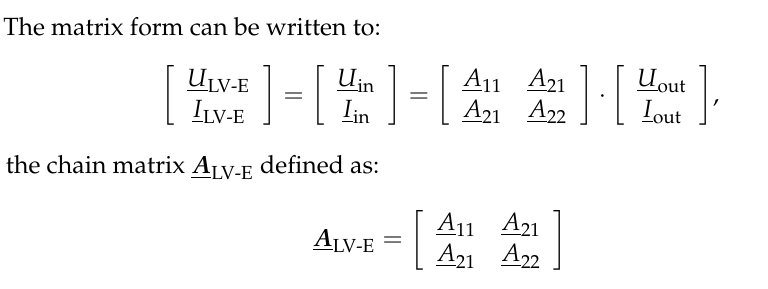
Figure 5. Mathematical simplification of the low voltage